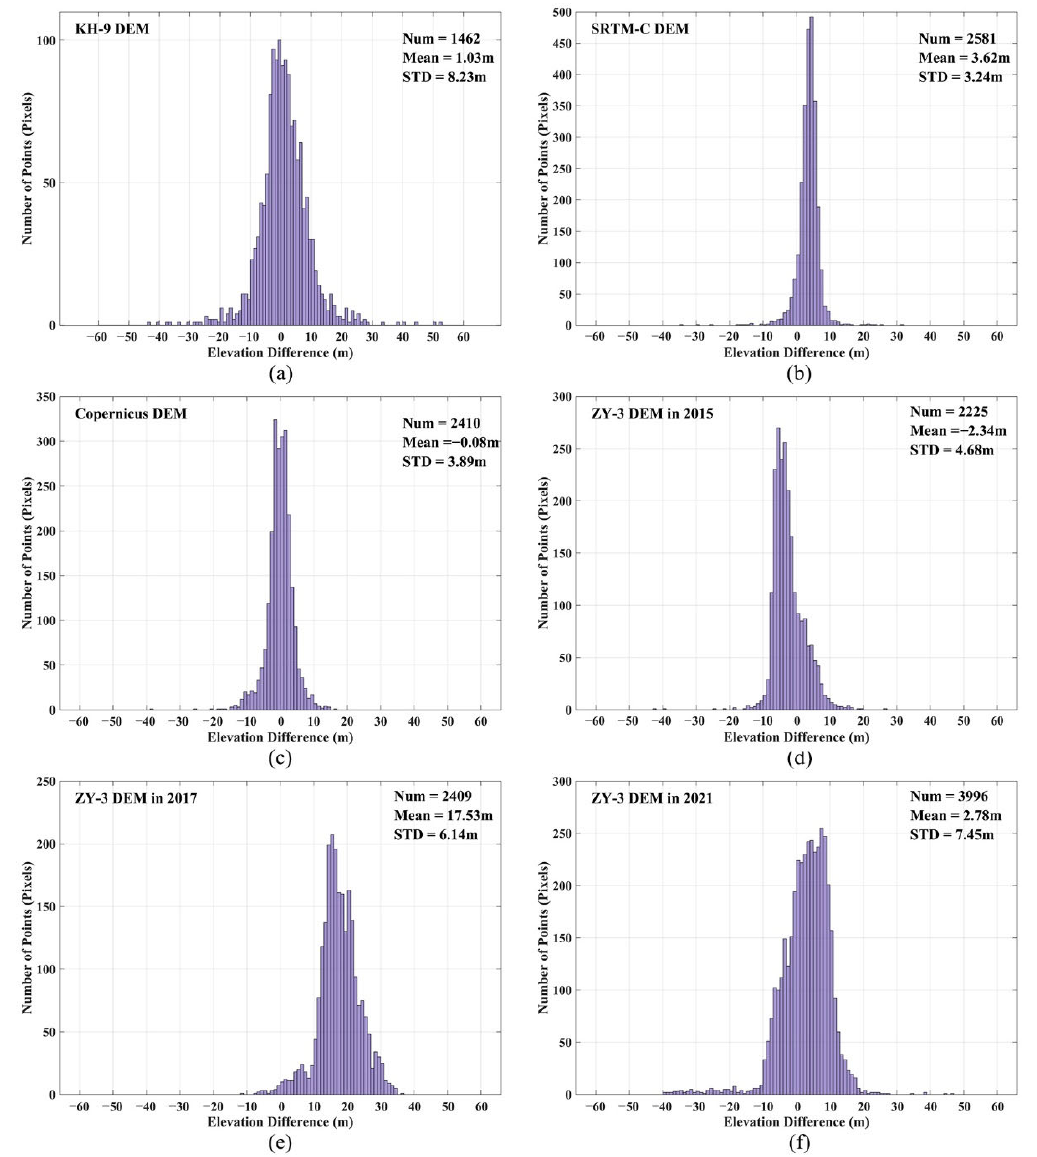
Figure 11. The distribution histograms of the elevation differences between the ICESat ‐ 1 data and the ( a ) KH ‐ 9, ( b ) SRTM ‐ C, ( c ) Copernicus and ( d ) ZY ‐ 3 DEMs from 2015, ( e ) the ZY ‐ 3 DEM from 2017 and ( f ) the ZY ‐ 3 DEM from 2021.